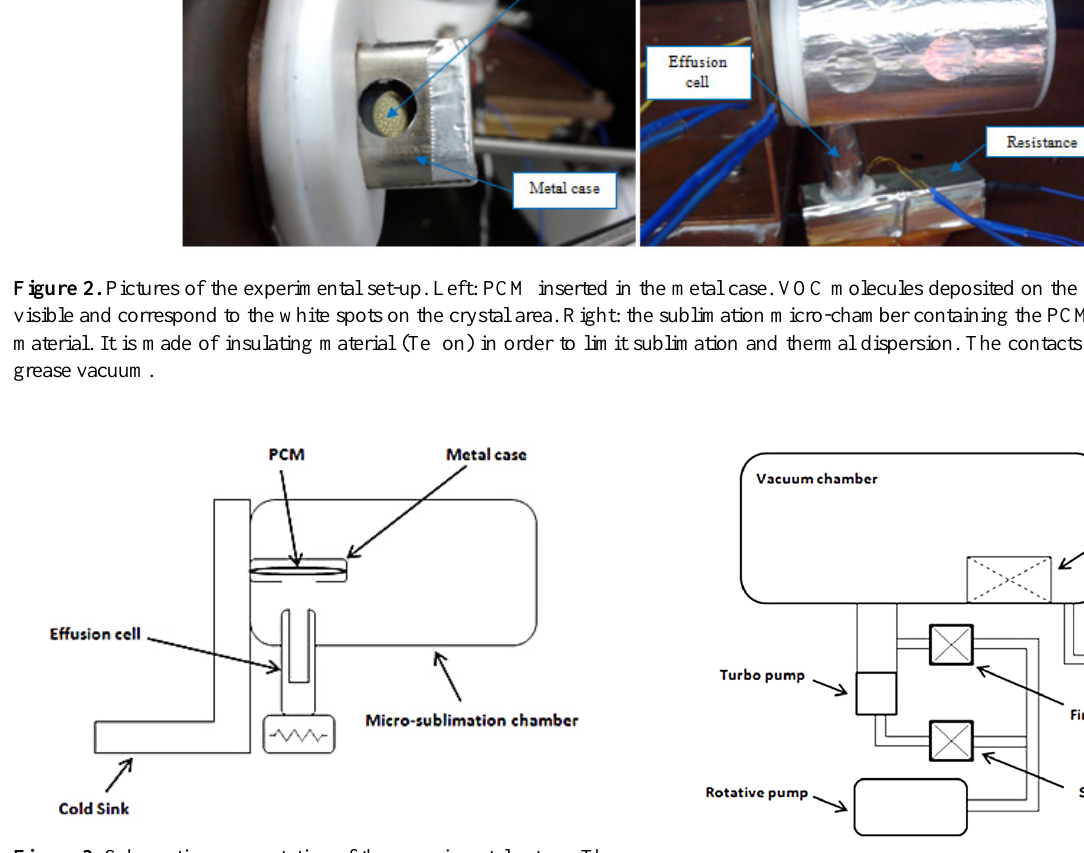
Figure 4. The vacuum system, composed of a rotative pump, turbo pump, and a vacuum chamber. Each pump is managed by an electro-valve: in the initial phase, the first valve (rotative) is opened, whereas the second valve is closed (turbo); in the next phase (at pressure of 10 − 2 mbar) the first valve is closed, whereas the second valve is opened (down to 10 − 6 mbar). The third valve is used to apply the re-entry in air at the end of each